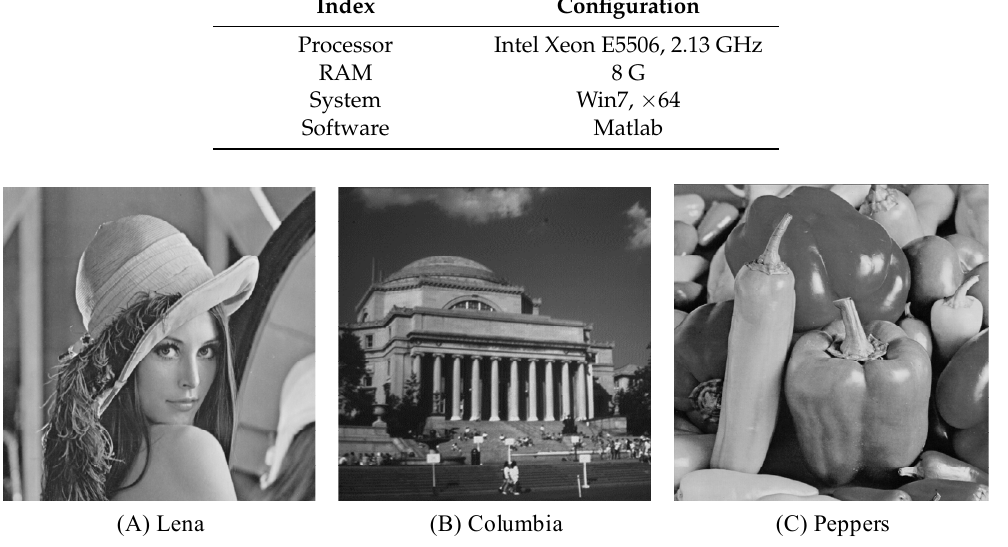
Figure 5. Original testing gray images (size: 512 × 512). ( A ) Lena; ( B ) Columbia; ( C ) Peppers.